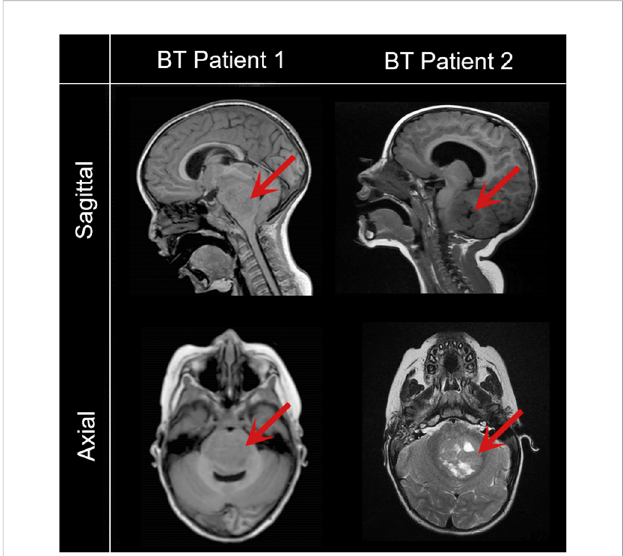
FIGURE 1 Representative magnetic resonance images of pediatric patients with brain tumors included in the study. Saggital and axial images reveal a low grade glioma (BT Patient 1, 43-month-old) and a metastatic brain tumor (BT Patient 2, 24-month-old). Red arrows point to the